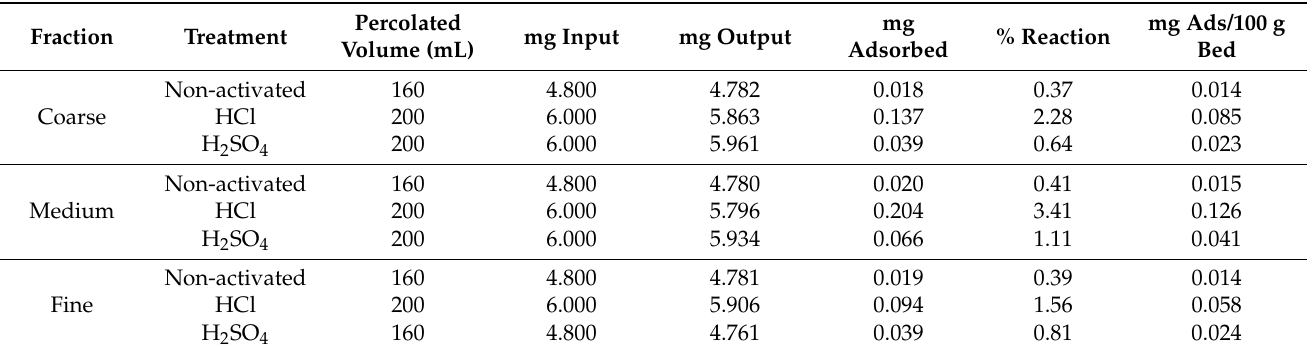
Table 6. Mass-balance of nitrate in the column experiments with the substrates treated with both HCl and H 2 SO 4